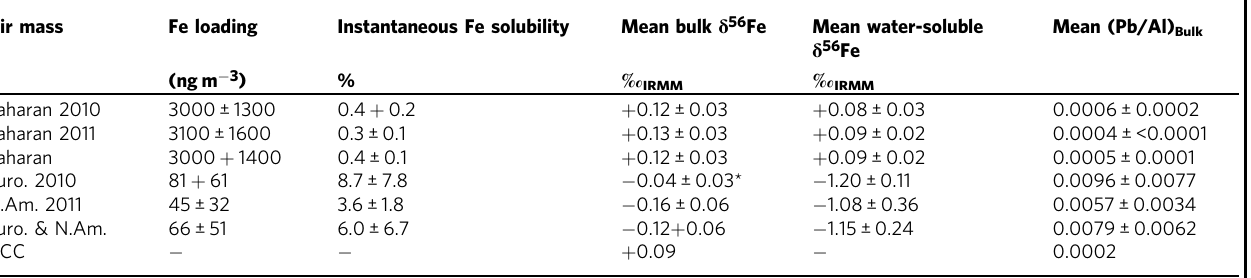
Table 1 Mean GA03 North Atlantic aerosol data (±1SD) for each air mass, as de fi ned by back-trajectory modeling 43 Air mass Fe